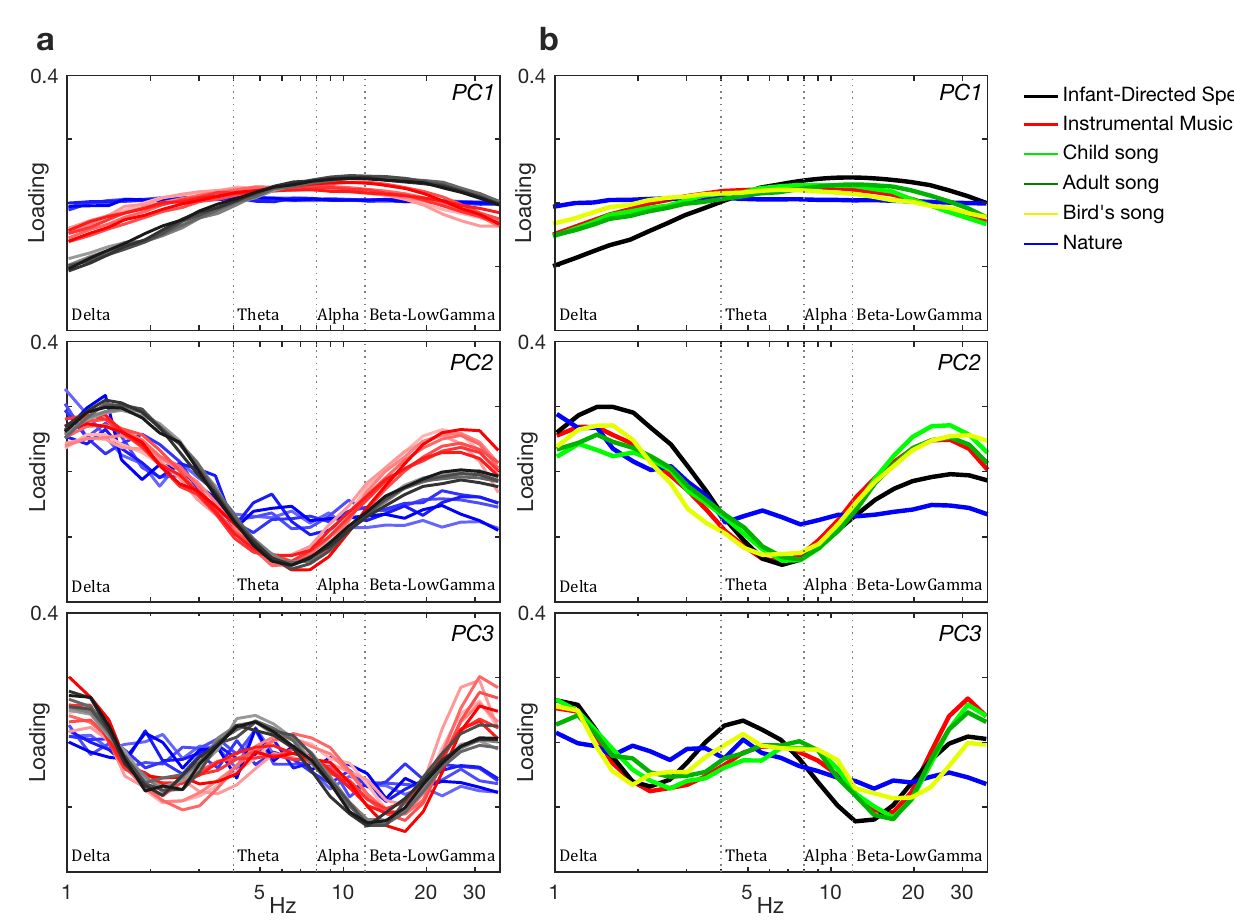
Fig 3. Core temporal modulation rates in S-AMPH. Grand average absolute value of the core temporal PCA component loading patterns in the S-AMPH. ( a ) Individual lines represent each of speakers (gray scale), musical genres (red scale) and nature sounds (blue scale). ( b ) Individual lines represent average of each speaker (black), music (red), child song (light green), adult song (dark green), bird song (yellow) and nature sound (blue). For detailed information about the core temporal bands and their flanking boundaries, please see Table c in S4